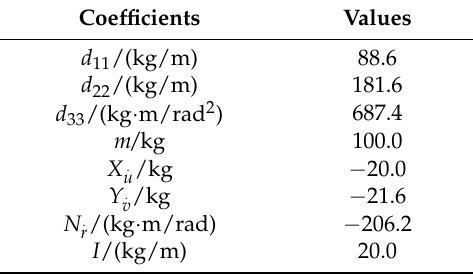
Table 1. USBV’s hydrodynamic coefficients.